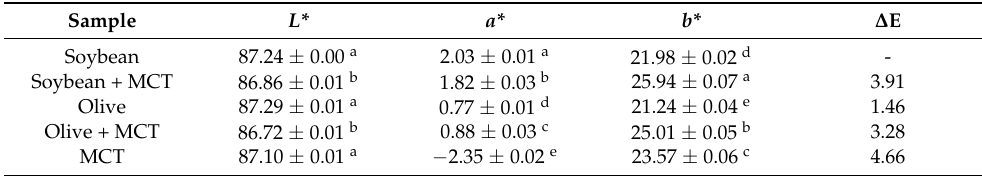
Table 3. Color analysis of the mayonnaise